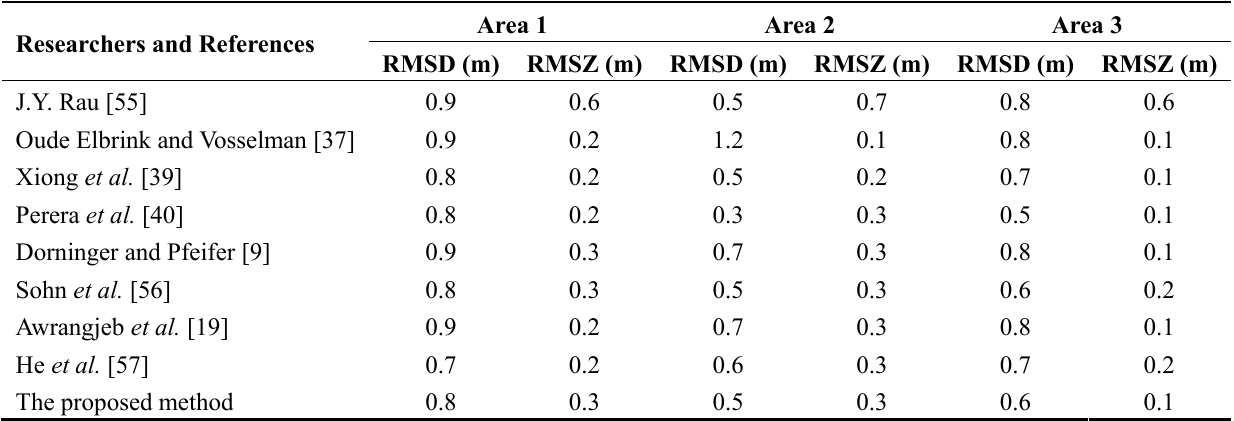
Table 1. Geometrical accuracy of different reconstruction methods in three test